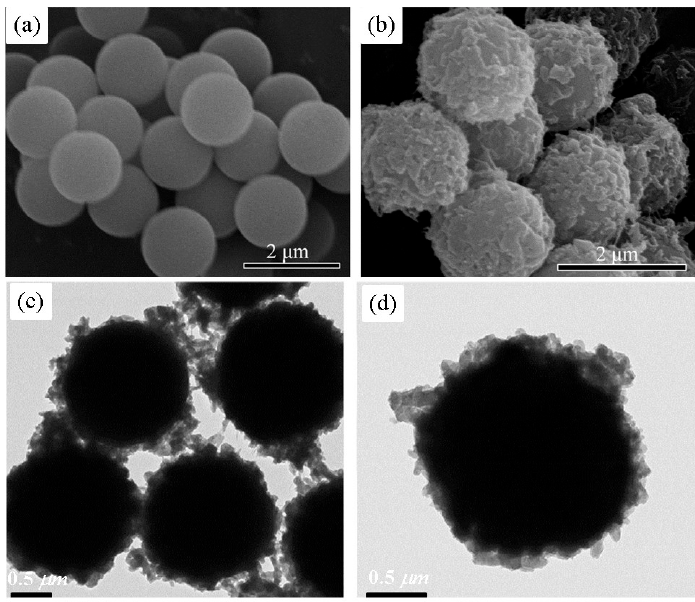
Figure 6. SEM images of ( a ) PGMA microspheres, ( b ) PGMA/PANI particles. In addition, ( c , d ) TEM images of PGMA/PANI particles. (Zhang et al. [123], Copyright Elsevier, 2013).